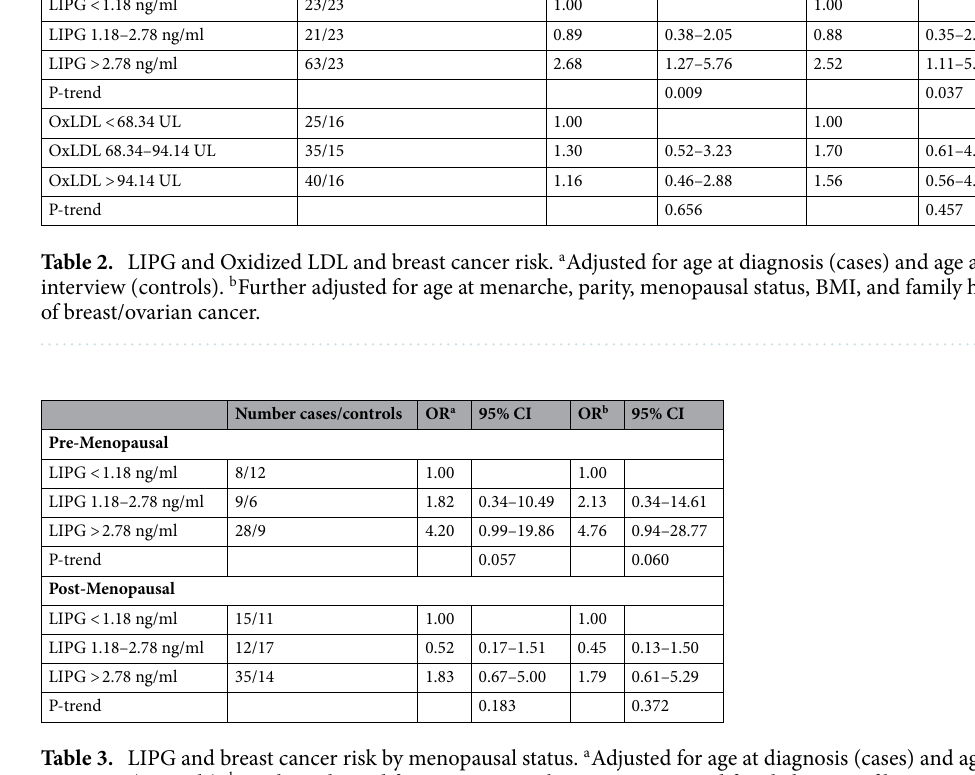
Table 3. LIPG and breast cancer risk by menopausal status. a Adjusted for age at diagnosis (cases) and age at interview (controls). b Further adjusted for age at menarche, parity, BMI, and family history of breast/ovarian cancer.